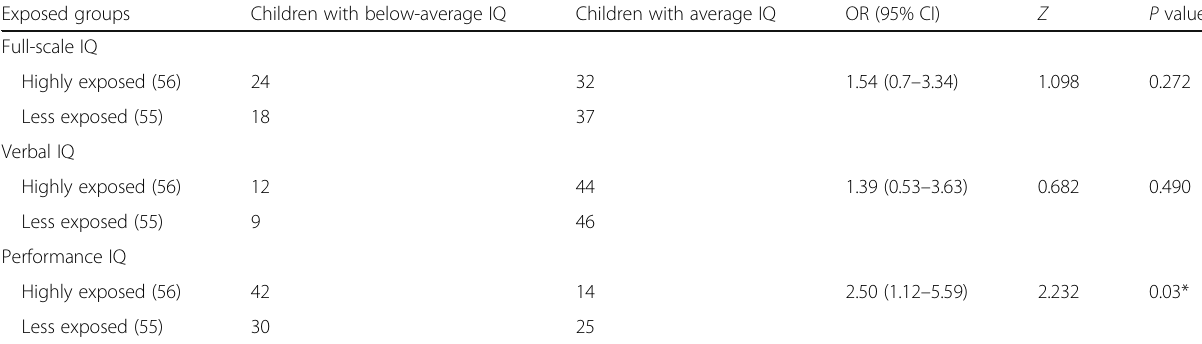
Table 3 The risk of below-average intelligence in relation to exposure to multiple adversities Exposed groups